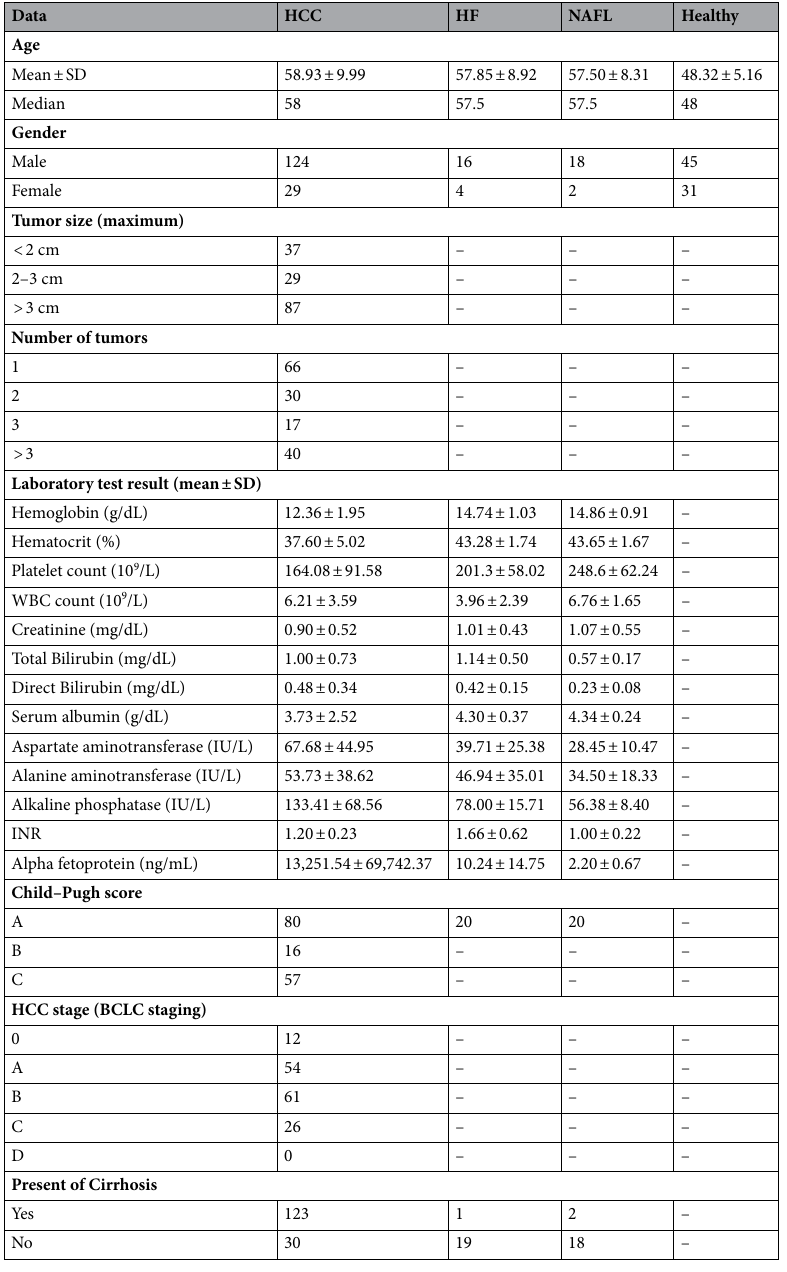
Table 2. Demographic data of samples. HCC (N = 153), HF (N = 20), NAFL (N = 20), Healthy Donor (N =